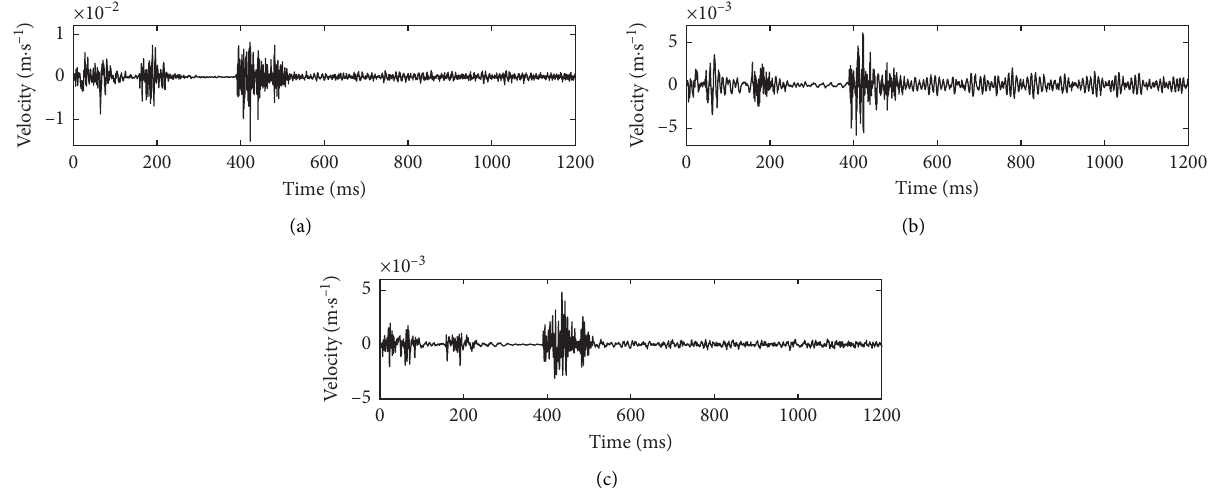
Figure 7: Measured typical seismic wave signal map. (a) Radial seismic wave signals. (b) Longitudinal seismic wave signals. (c) Verticle seismic wave